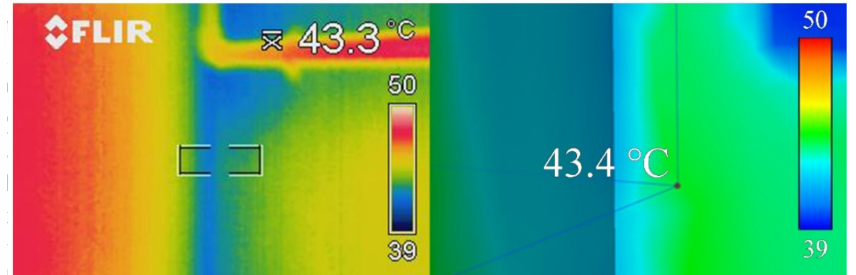
Figure 10. Comparison between data obtained by using the thermal camera and data simulated by CFD analysis at the north wall.